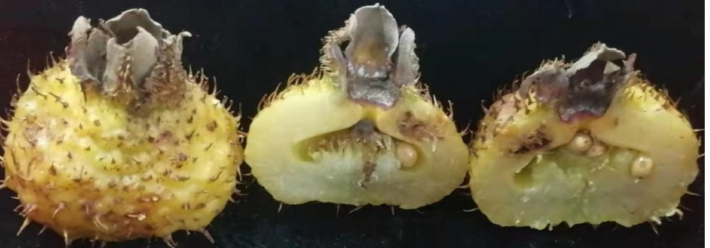
Figure 1. External and internal morphology of “Guinong 5” Rosa roxburghii Tratt fruit used in this